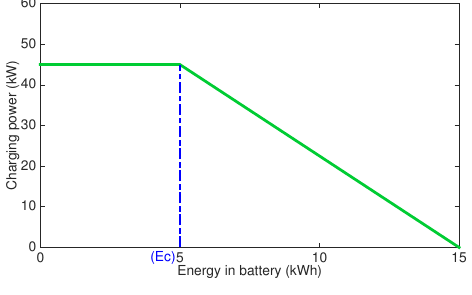
Figure 2. Charging power function